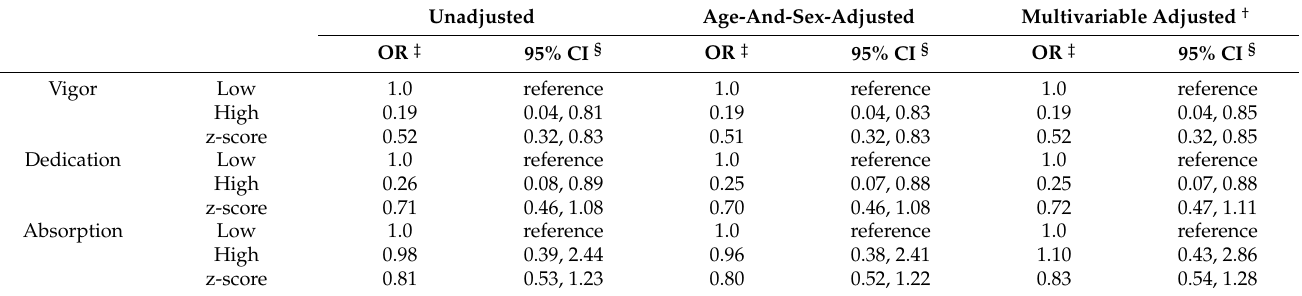
Table 2. The association of the work engagement subdimensions vigor, dedication, and absorption with concerns about having made an important medical error in the last three months (n =